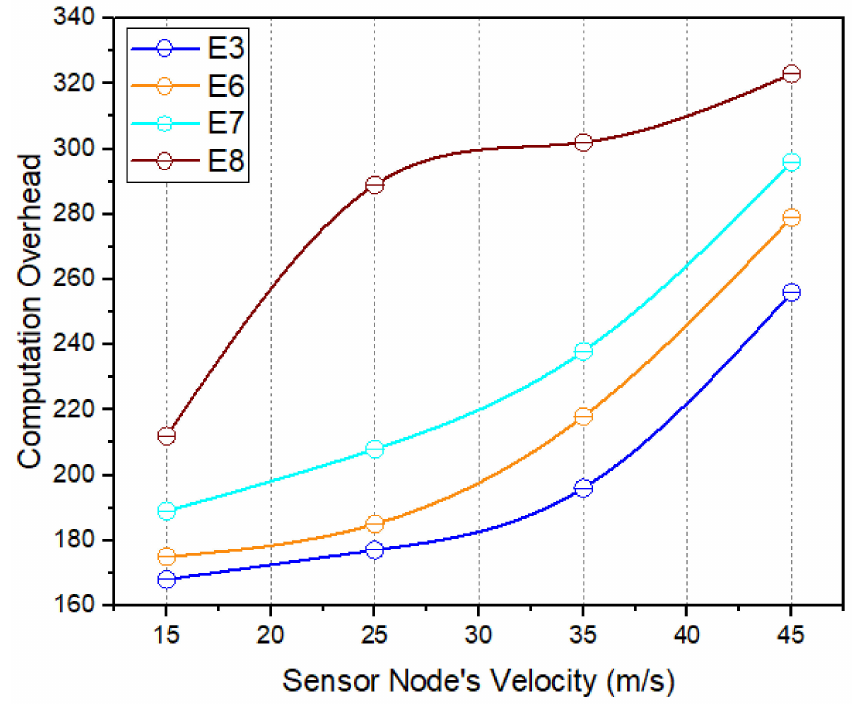
Figure 12. Overall computation